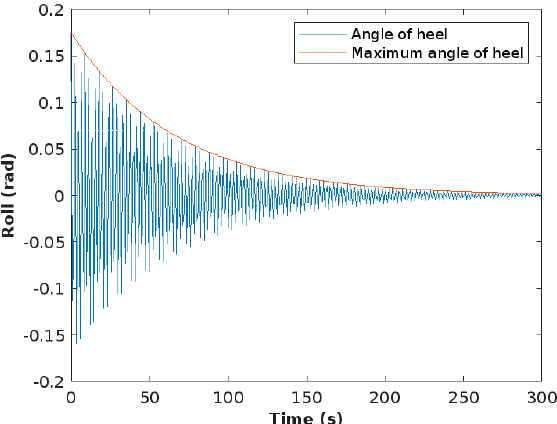
Figure 3. Representation (red colour) of the exponential limit curve of a ship’s rolling motion under the in fl uence of a single and external force.